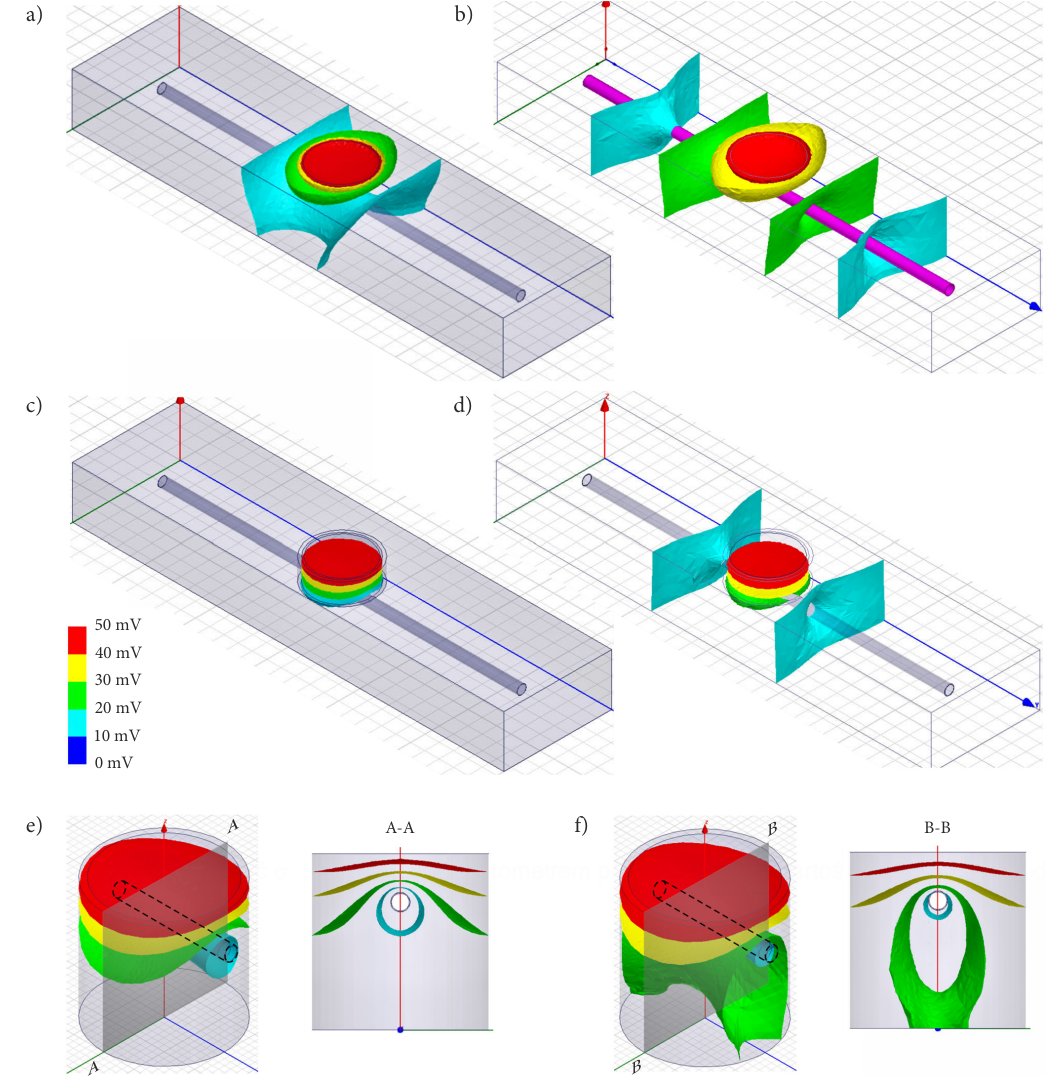
Figure 3. Results of FEM simulation using ANSYS Maxwell – description in the